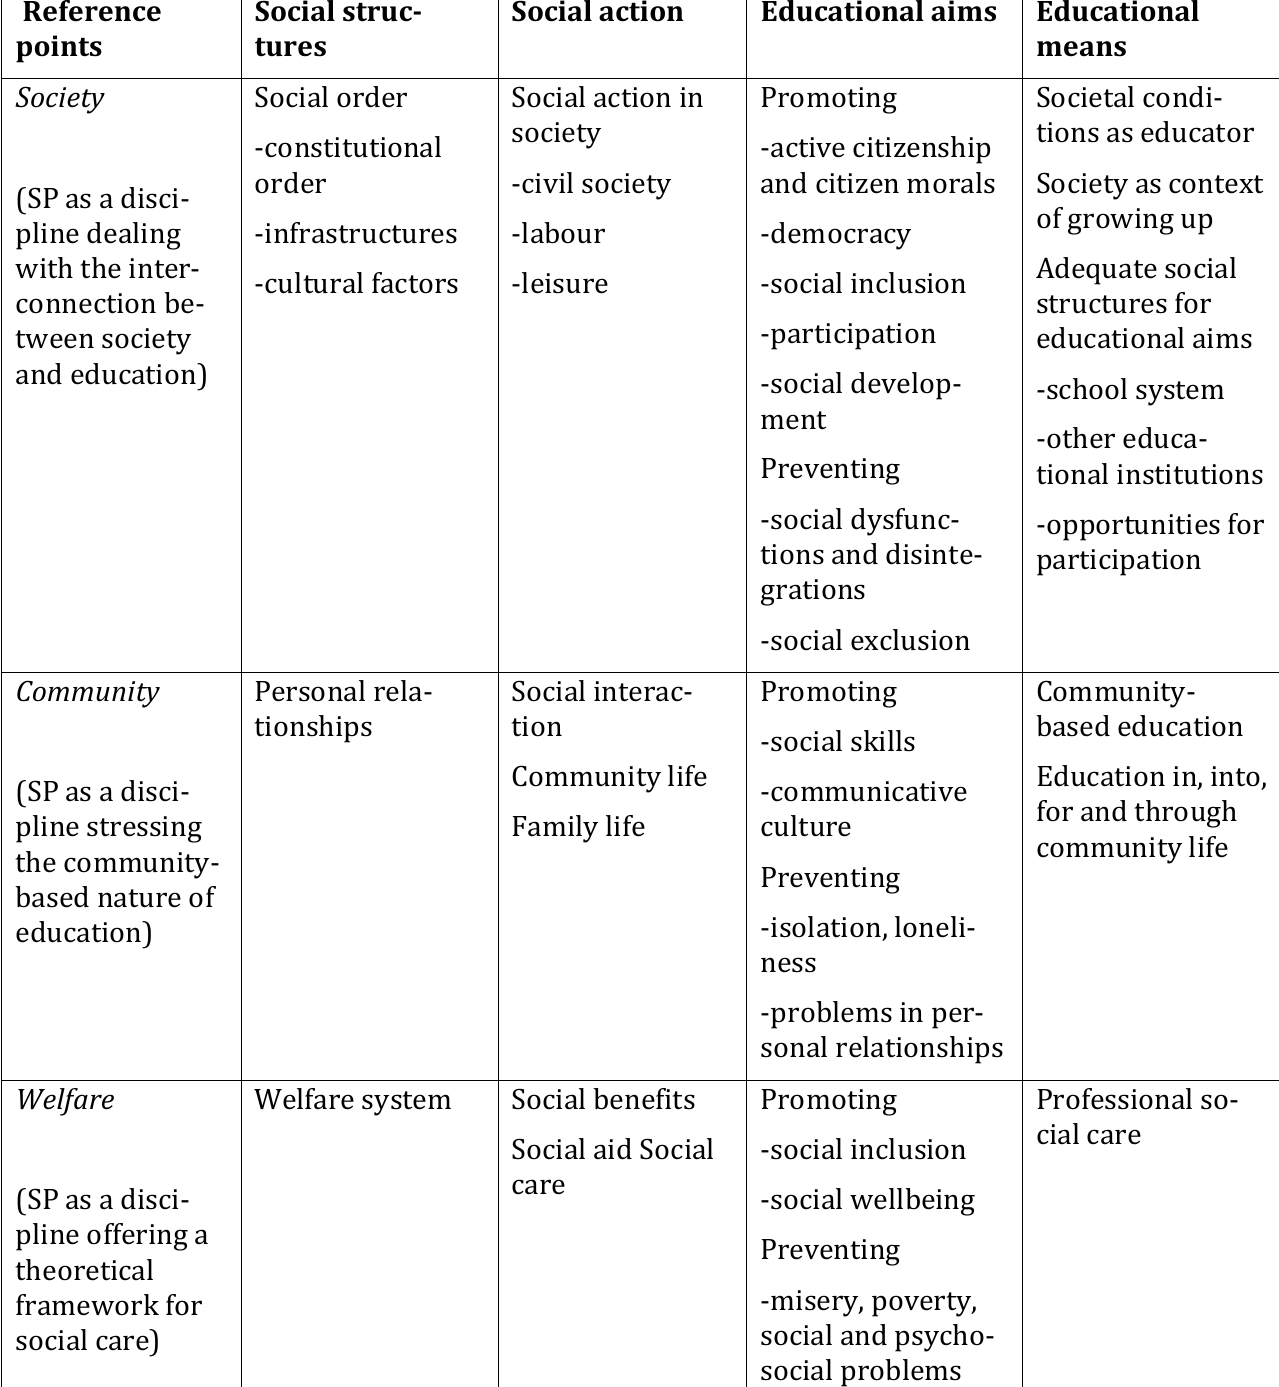
Table 1. Semantic varieties of social